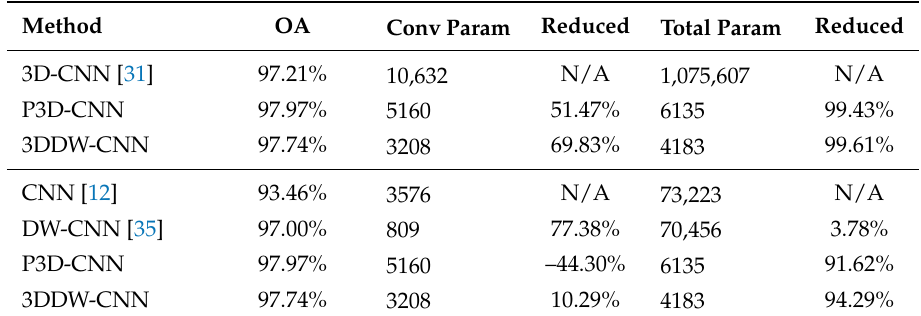
Table 8. Comparison of the number of contained model parameters between different architectures on the AIRSAR Flevoland